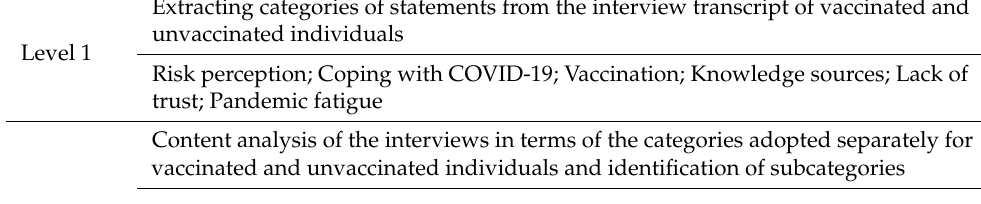
Table 2. The process of conventional analysis and coding respondents’